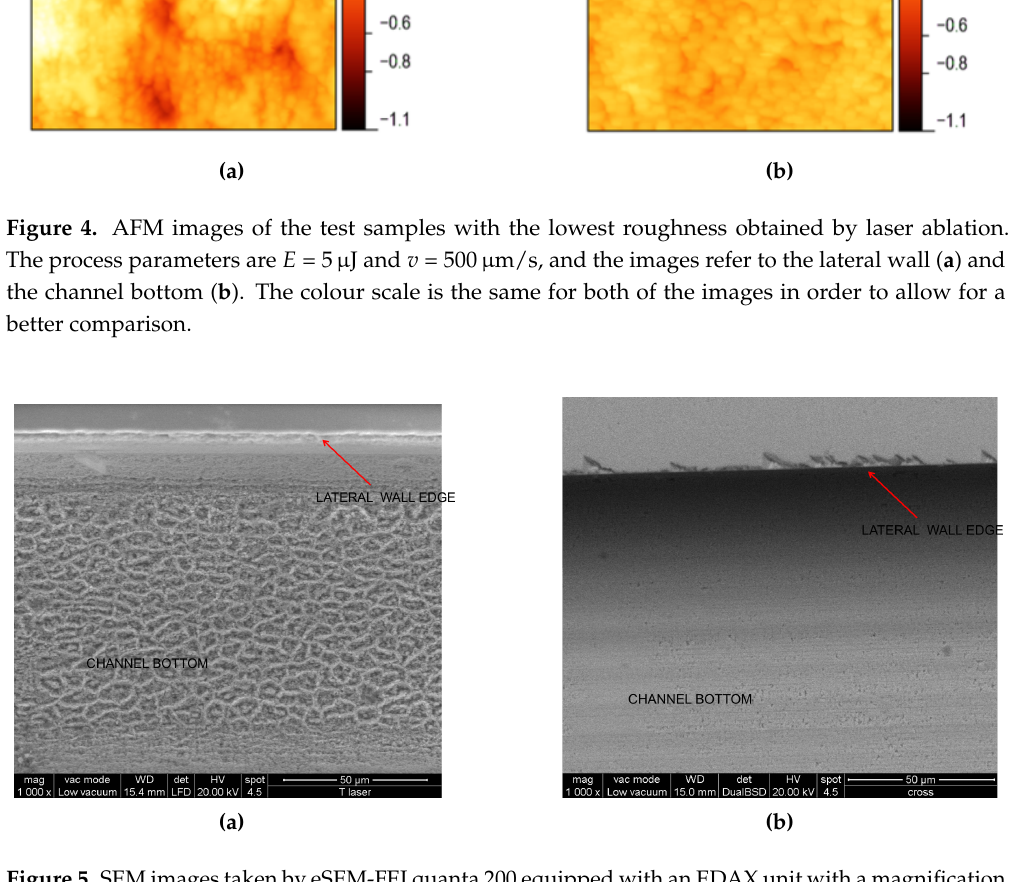
Figure 5. SEM images taken by eSEM-FEI quanta 200 equipped with an EDAX unit with a magnification of × 1000. SEM images of the test samples with the lowest roughness obtained by laser ablation ( a ) and dicing technique ( b ); the top view of a channel engraved by laser ablation at E = 5 µ J and v = 500 µ m/s; the top view of a channel engraved by the dicing